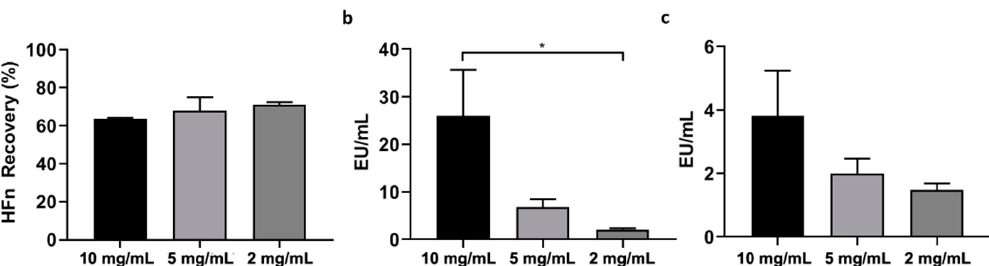
Figure 4. Scale-up of Triton X-114. 1% Triton X-114 has been added to HFn at different concentrations (2, 5 and 10 mg/mL) to remove ETX through 4 incubation cycles, as reported in panel a. HFn recovery was calculated by absorbance reading ( a ), while ETX levels have been obtained by LAL test ( b , c ). Results are reported as average ± S.D. of 4 independent experiments. Statistical significance: * p = 0.0487.